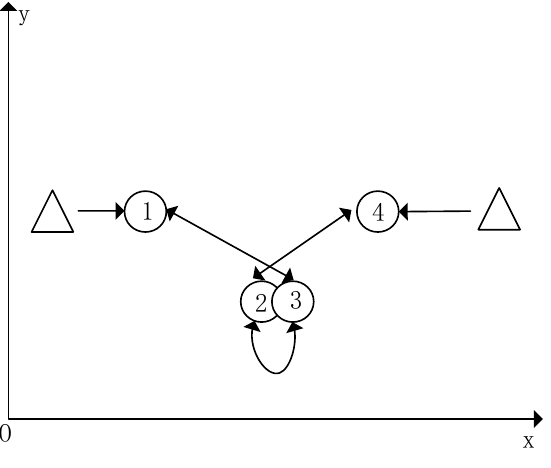
Figure 2. Spatially Discretized Communication Topology. USVs index by 2 and 3 collide during formation. Legend: (cid:52) = leaders; (cid:13) =